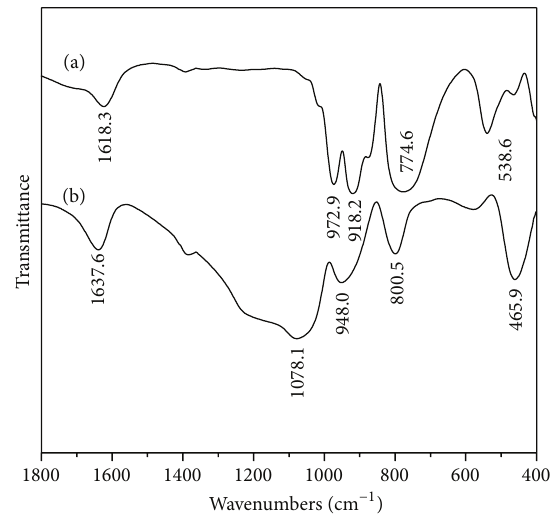
Figure1:FT-IRspectraofH 4 SiW 6 Mo 6 O 40 (a)andH 4 SiW 6 Mo 6 O 40 / SiO